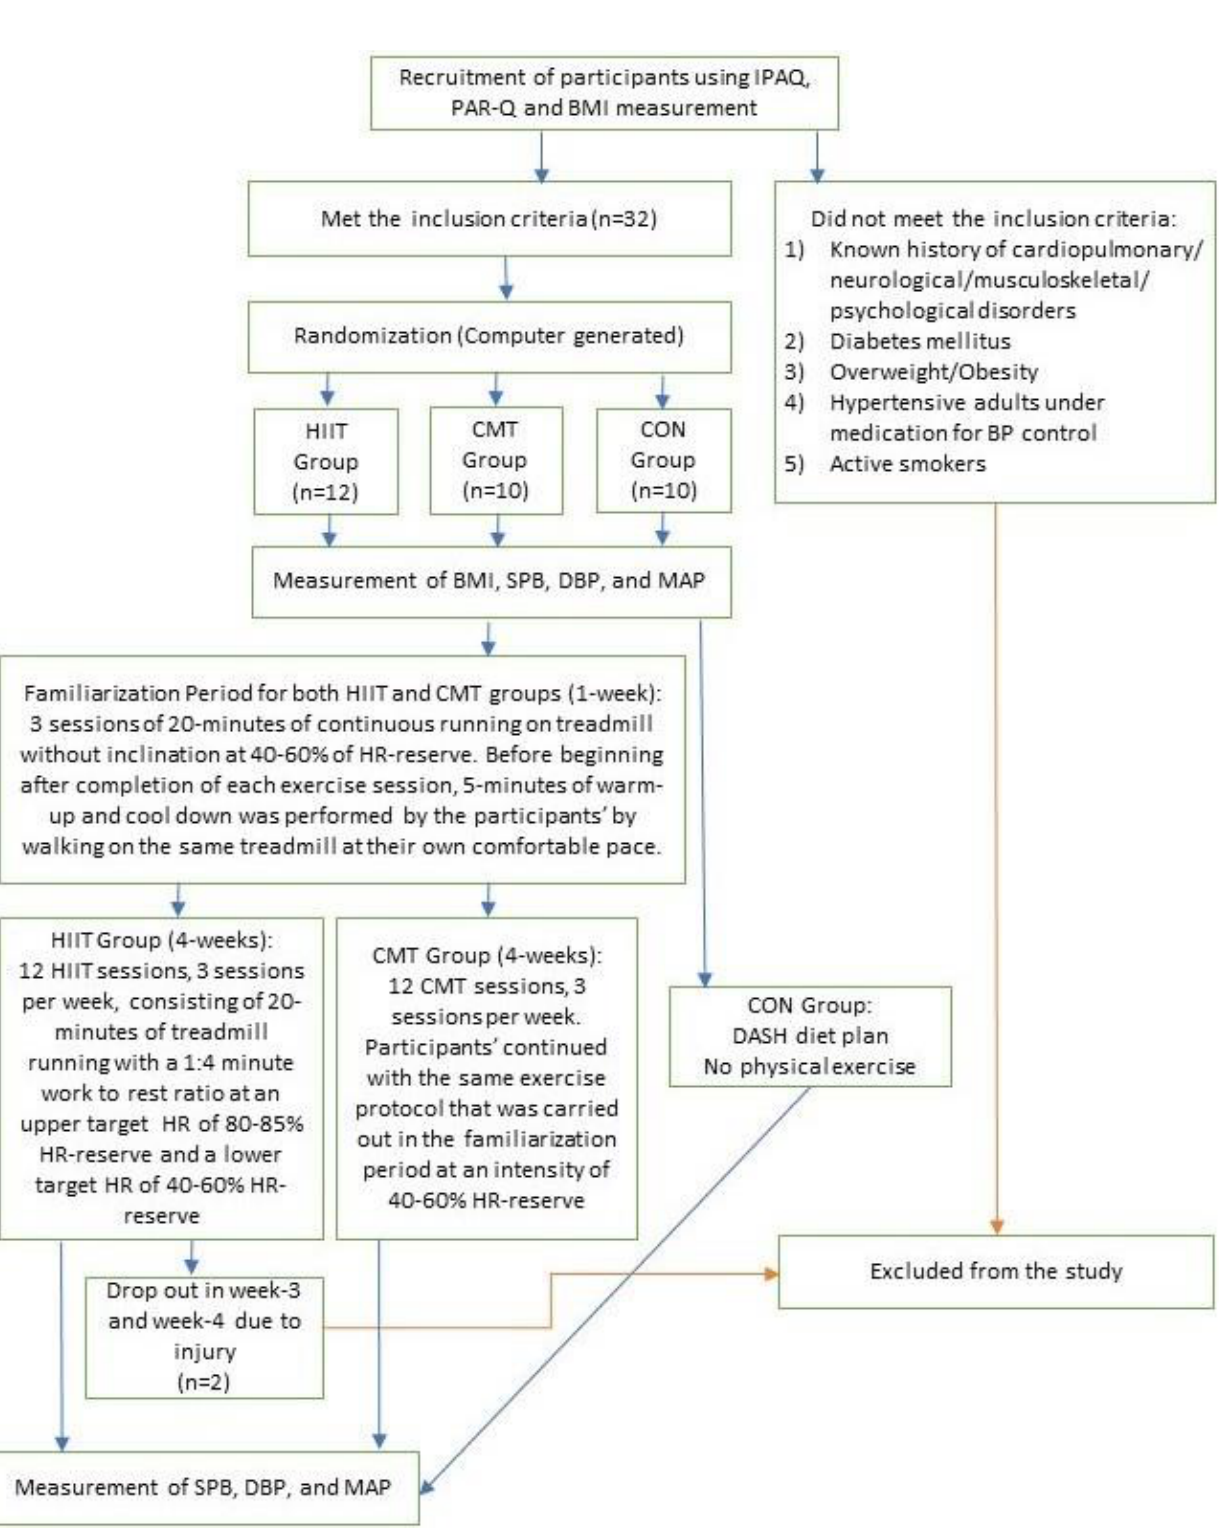
Figure 1. Flowchart of Trial: IPAQ = International Physical Activity Questionnaire; PAR-Q = Physi- cal Activity Readiness Questionnaire; BMI = Body Mass Index; SBP = Systolic Blood Pressure; DBP = Diastolic Blood Pressure; MAP = Mean Arterial Pressure; HIIT = High Intensity Interval Training; CMT = Continuous Moderate-intensity Training; CON = Control; HR-reserve = Heart Rate Reserve.